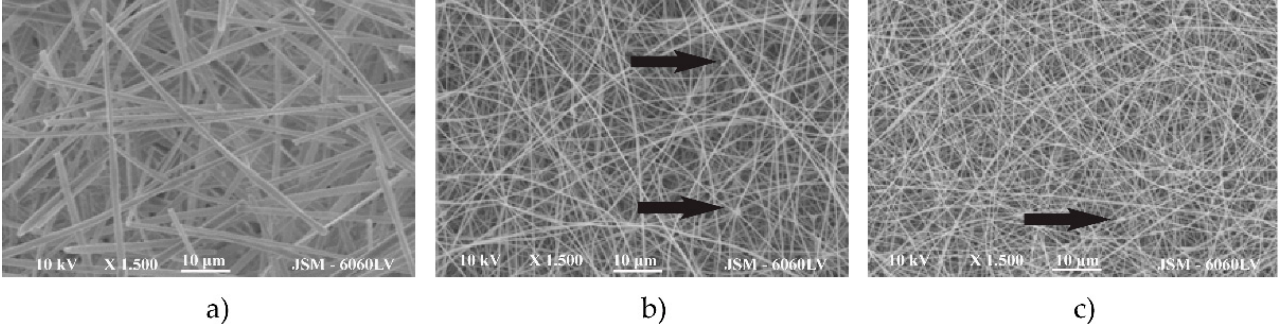
Figure 5. SEM micrographs of final material ( a ) optimal-electrospun from suspension with a viscosity of 20,000 mPas; ( b ) electrospun from suspension with a viscosity of 5000 mPas; ( c ) electrospun from suspension with a viscosity of 2000 mPas at 1500× magnification.